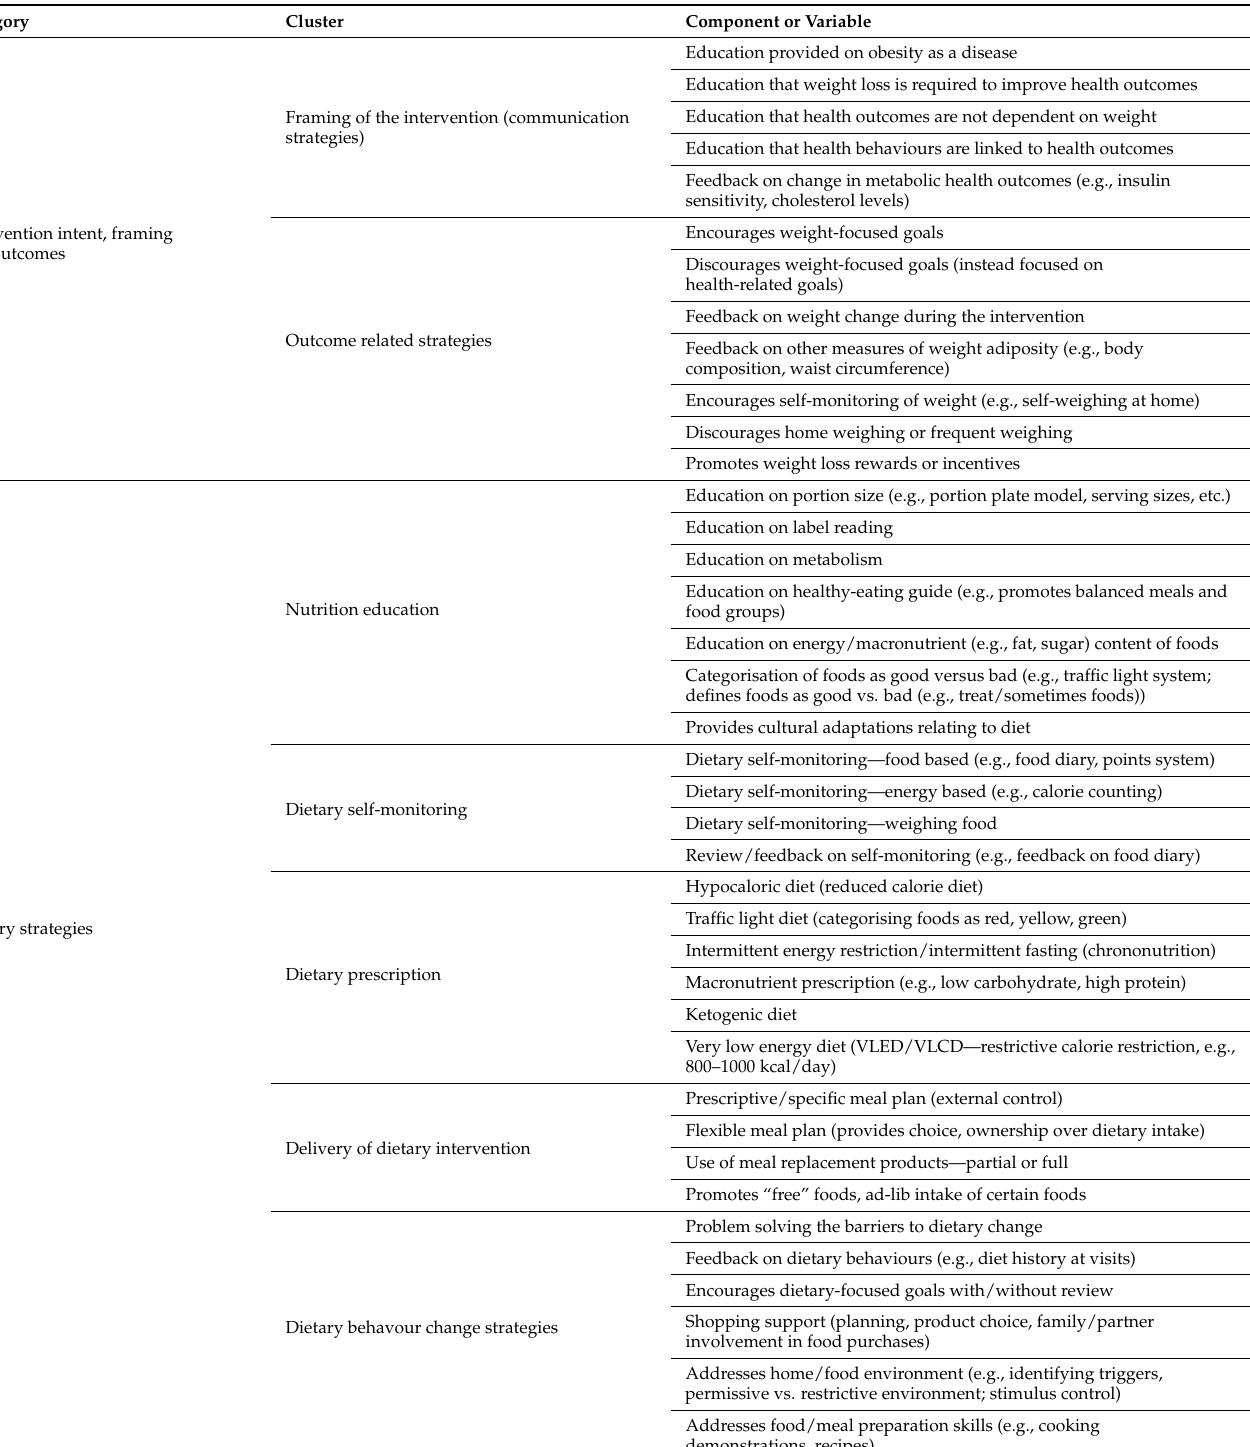
Table 3. Codebook for intervention